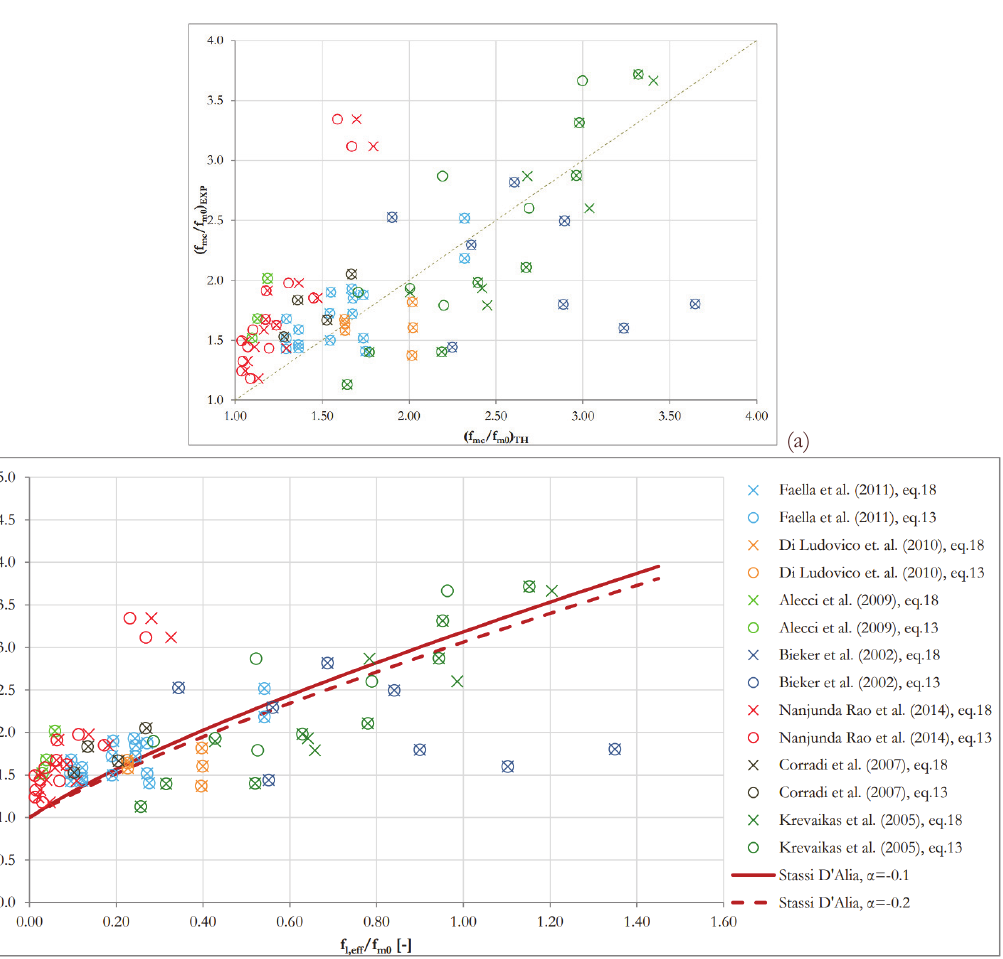
Table 1: Value of the normalized tensile strength of masonry,  for the experimental programs.